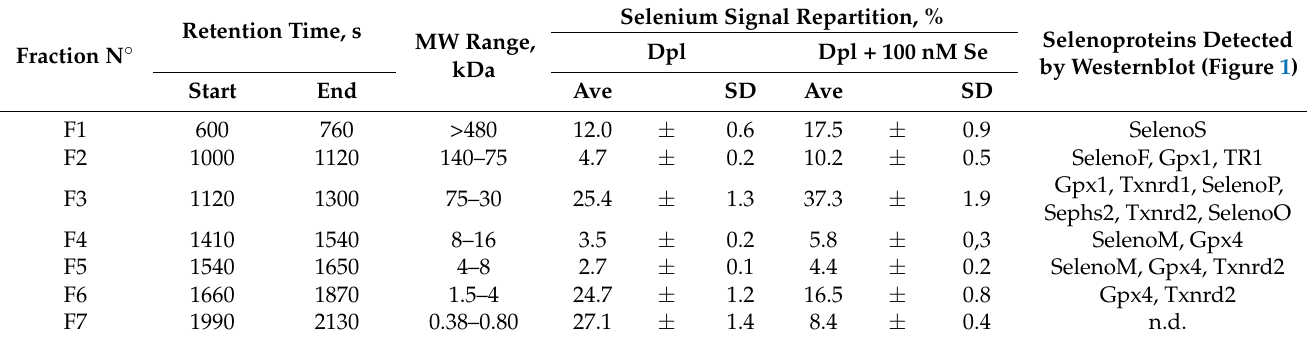
Selenoproteins Detected by Westernblot (Figure